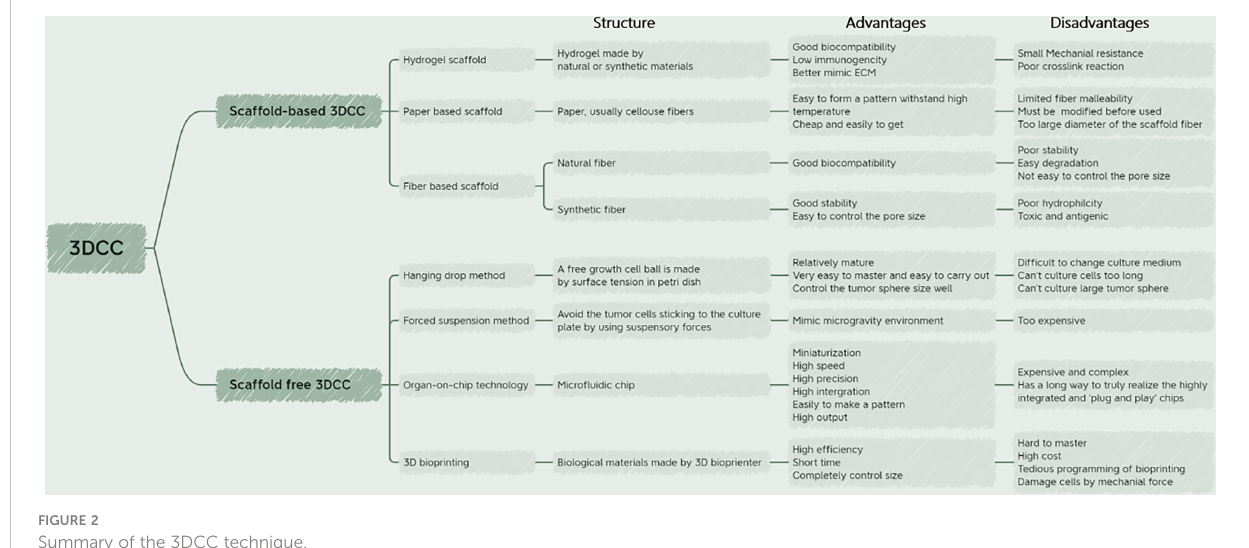
FIGURE 2 Summary of the 3DCC technique.